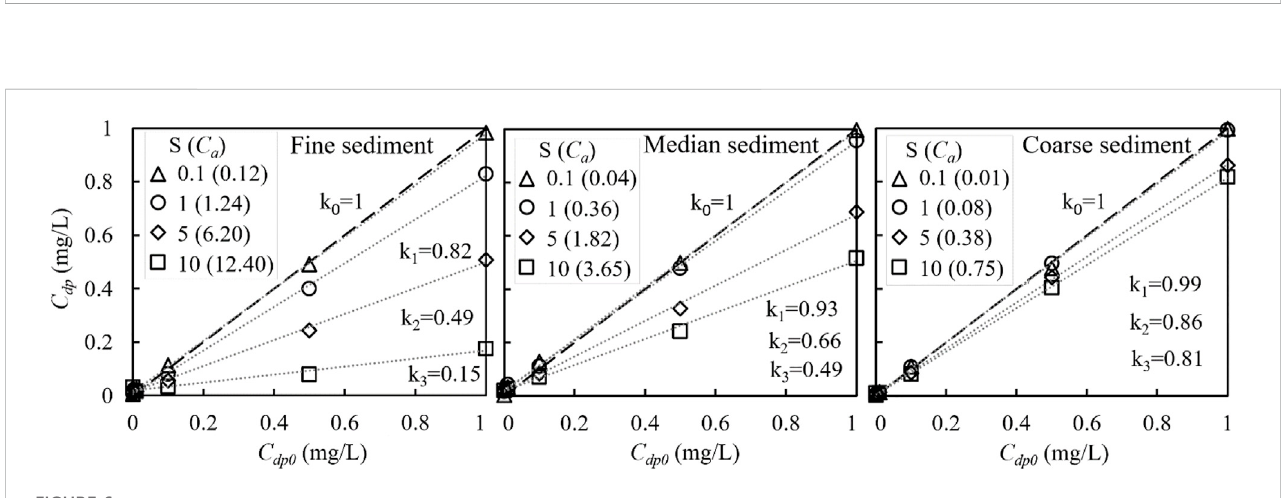
FIGURE 6 Effect of P pollution condition (indicated by the initial dissolved P concentration, C dp0 ) on dissolved P concentration ( C dp ) at adsorption equilibrium. The k 0 ~k 3 denotes the slope between C dp0 and C dp when S = 0 (clear water, meaning no adsorption occurs), 1, 5, and 10 g/L, respectively. The units of sediment concentration ( S ) and surface area concentration of sediment ( C a ) are g/L and m 2 /L, respectively. Panels correspond to fi ne ( D 50 = 4.61 µm), median ( D 50 = 20.89 µm), and coarse ( D 50 = 51.56 µm)